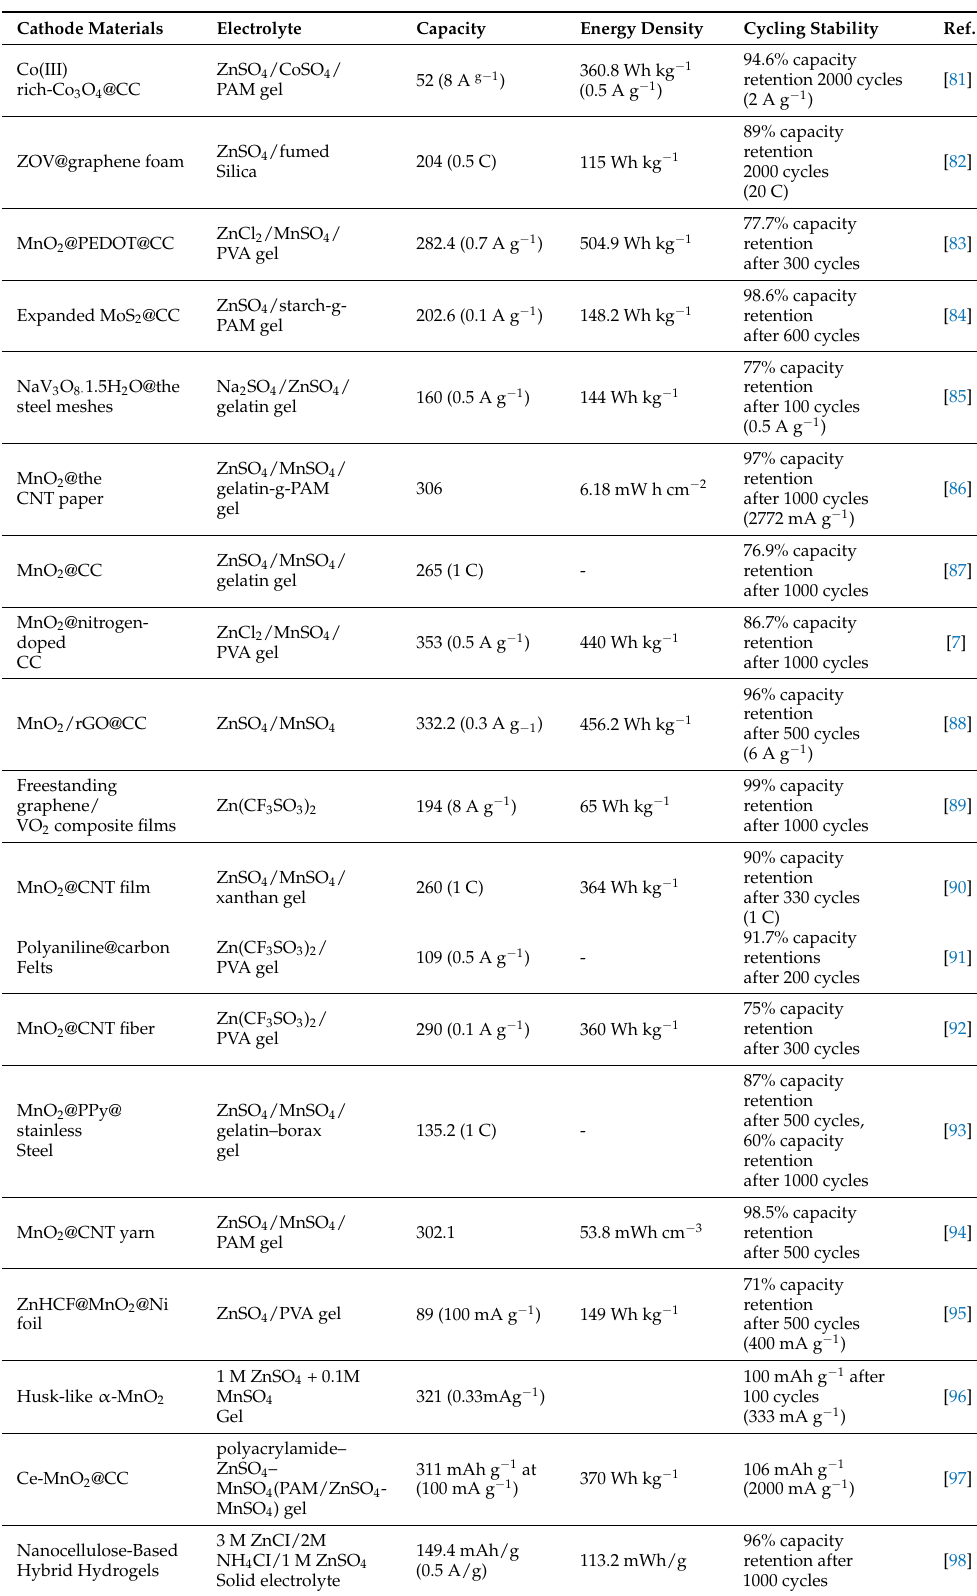
Table 2. The recent updates of the flexible zinc-ion